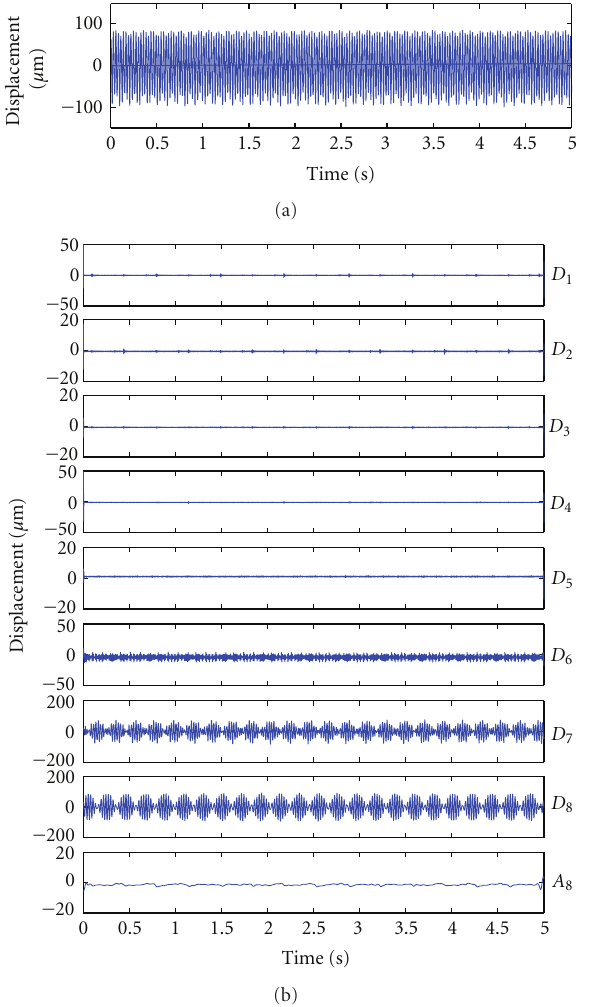
Figure 7: Time series plot (a) and multiresolution decomposition (b) of the vibration signal for cracked rotor with excitation.